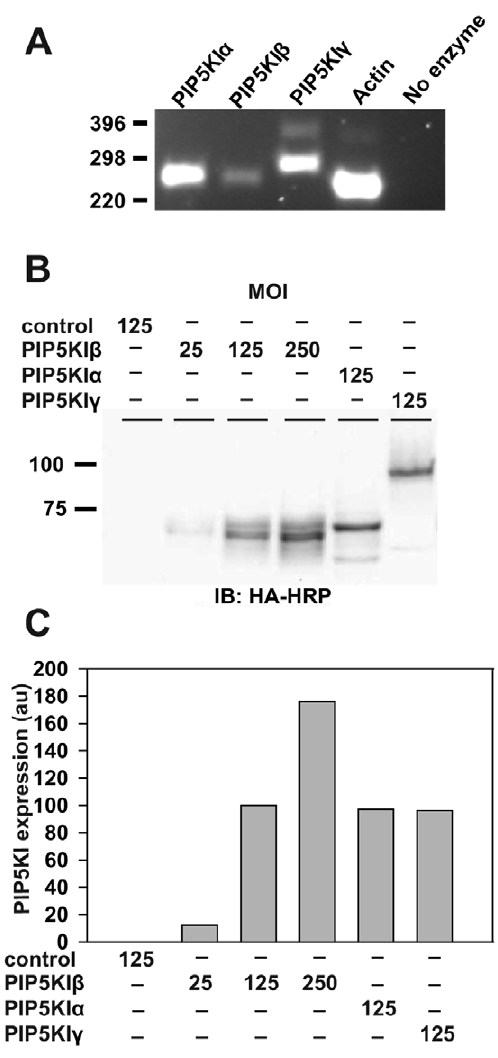
Figure 1. Endogenous and adenovirus-mediated expression of PIP5KI isoforms in renal epithelial cells. (A) Reverse-transcriptase PCR of mRNA isolated from mCCD cells was performed to detect expression of endogenous PIP5KI isoforms. Actin was amplified as a positive control, and actin primers were included in the sample with no enzyme. Predicted sizes are 246 (PIP5KI a ), 247 (PIP5KI b ), 276 (PIP5KI c ), and 231 bases (actin). (B) Polarized mCCD cells were mock- infected or infected with adenoviruses encoding HA-tagged PIP5KI a , PIP5KI b , or PIP5KI c isoforms at the indicated multiplicity of infection (MOI). Cell lysates were harvested and western blotted using anti-HA antibody to detect PIP5KI expression. The expected masses are approximately 68 (PIP5KI a and PIP5KI b ) and 91 kDa (PIP5KI c ). (C) Densitometric quantitation of the western blot above using arbitrary units (au) normalized to PIP5KI b MOI 125 demonstrates that PIP5KI b expression at different MOIs is linear and that expression levels of all three isoforms at MOI 125 is